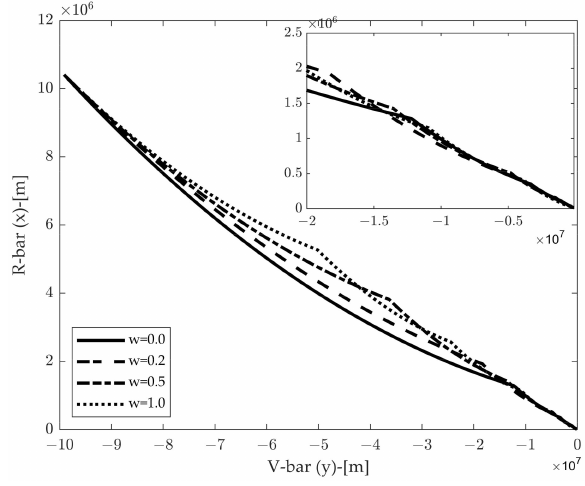
Figure 4. Resulting optimal trajectories corresponding to different tradeoff weights w .